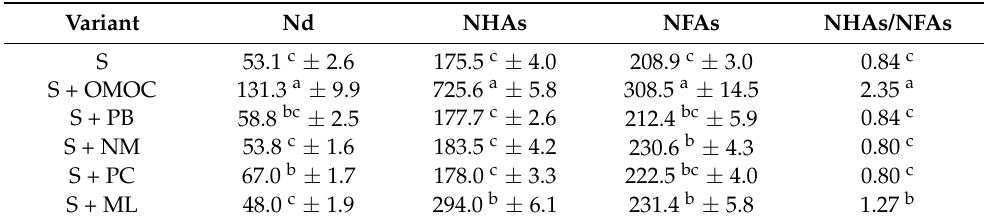
Table 5. Mean content of nitrogen (mg kg − 1 ) in the humus